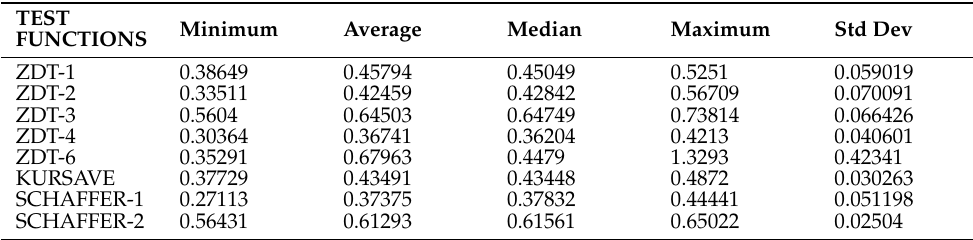
Table 7. Results of SPREAD METRICS on test